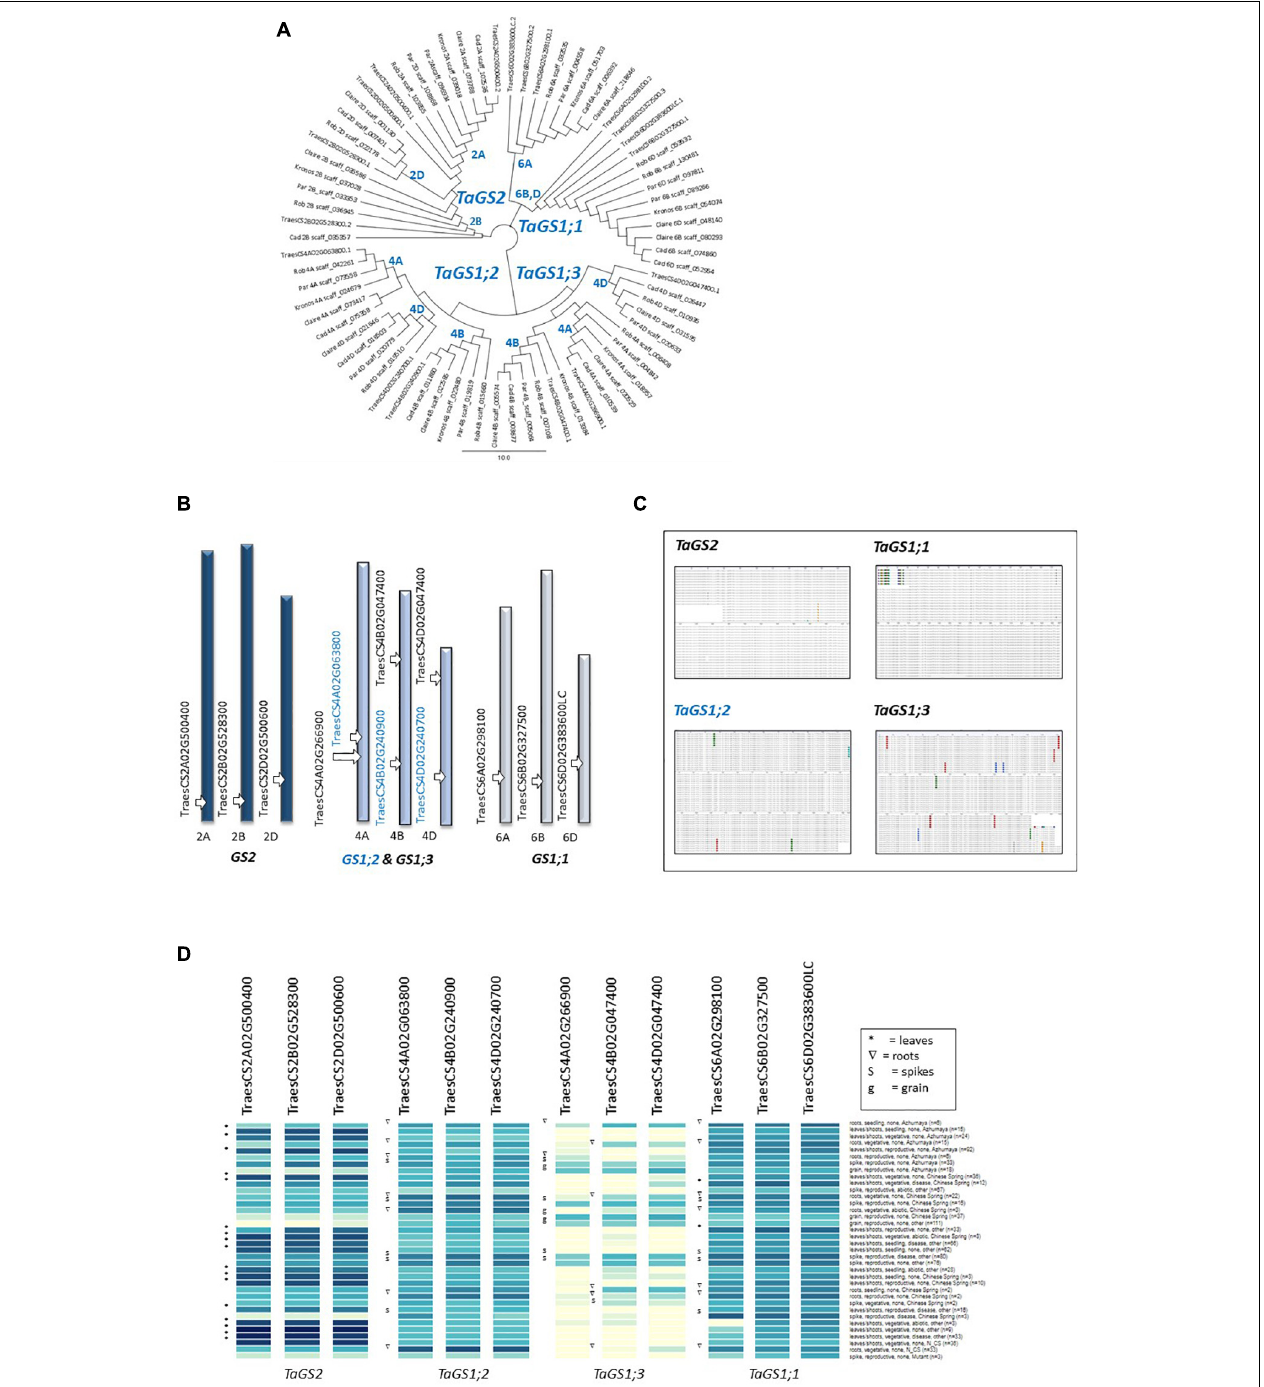
FIGURE 2 | Comparison of glutamine synthetase genes in six wheat varieties. Sequences of the wheat GS1 and GS2 genes of the reference Chinese Spring reference genome were extracted from Ensembl Plants (https://plants.ensembl.org/Triticum_aestivum) and used as a query and template to extract genomic sequences from publicly available scaffolds and to predict GS1 and GS2 protein models in four bread wheat varieties (Cadenza, Paragon, Claire, and Robigus) and one durum wheat (Kronos) (see text for details; Supplementary Table 1 ). A comparison of the protein models is shown in the tree generated in Geneious (A) . The gene IDs and chromosomal positions of the genes in the Chinese Spring reference genome are shown in (B) . The high degree of conservation of the genes across the six analysed varieties is shown in the alignment in (C) (see Supplementary Figures 1–3 for details). Available gene expression data (http://www.wheatexpression.com) show a preferential expression of GS2 in leaves, and the additional expression of GS1 genes in roots, spikes and grain (D) . Note that the GS1;3 genes show a distinct expression pattern and had the highest number of amino acid changes (C) (http://www.wheatexpression.com; Ramírez-González and Borrill,